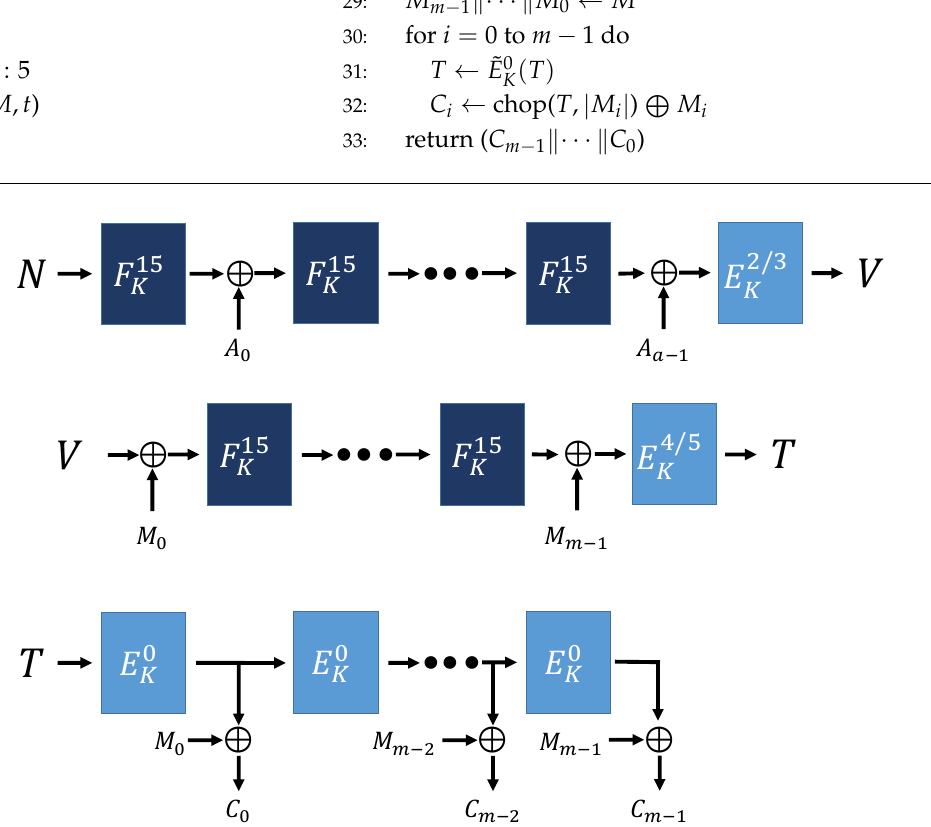
Figure 9. sESTATE mode (using AD and Message)